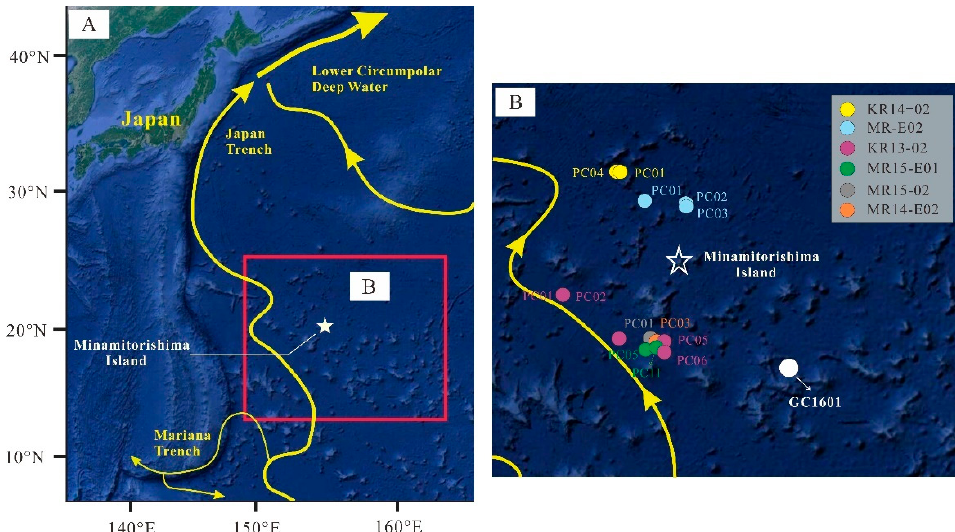
Figure 9. Locations of the Northwest Pacific and GC1601 core (Base map according to Google Earth). ( A ) Location of Northwest Pacific, the yellow lines represent Lower Circumpolar Deep Water (LCDW) in this area [68,69], the red highlighted by the red rectangle in ( A ) is shown in ( B ). ( B ) Locations of GC1601 and other sediments cores in the Sea area of Minamitorishima Island, these colored sediments cores are from [7,10].